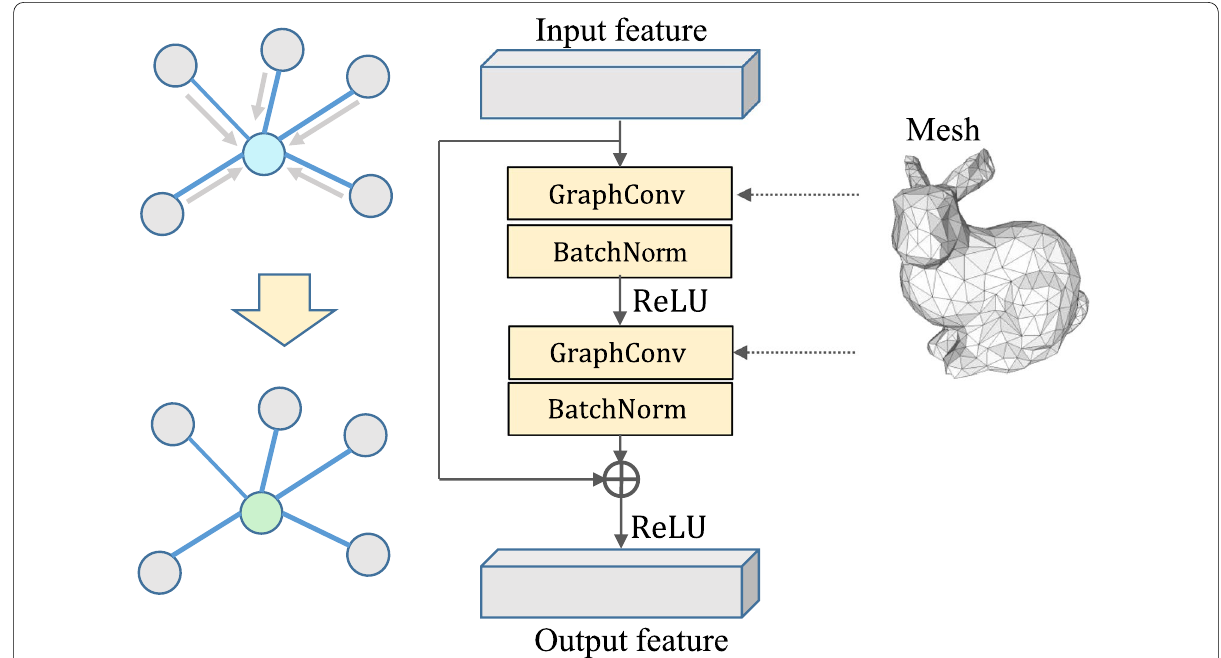
Fig. 2 Graph residual block. The dashed line represents that the mesh is utilized for querying the adjacent vertices in GraphConv operation